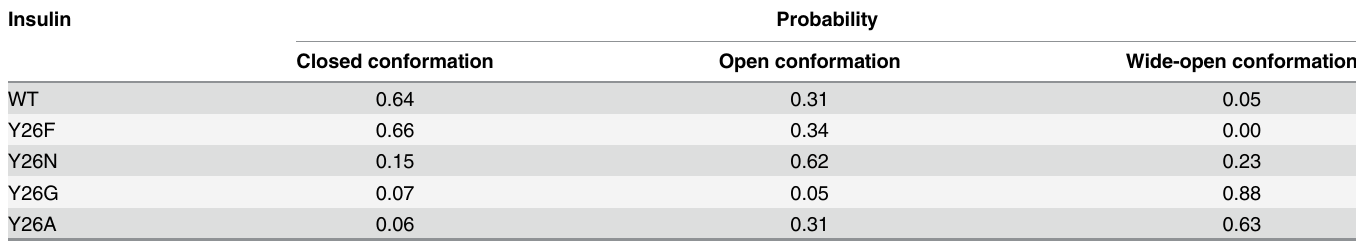
Table 3. Probabilities of the closed, open, and wide-open conformations of the BC-CT for WT and mutated insulin.